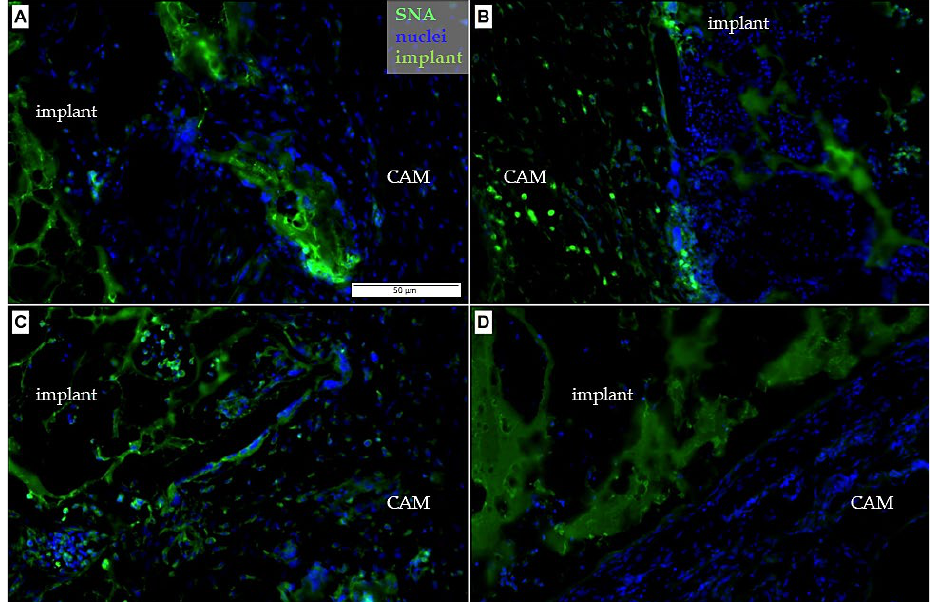
Figure 7. Immunohistochemical detection of the embryonic endothelium in the porous PHB/CHIT scaffolds using the SNA marker. ( A – D ) The presence of the SNA positive cells in the surrounding area of the porous scaffolds as well as inside of the pores of the PHB/CHIT was observed suggesting presence of endothelial cells of blood vessels. Treating of the scaffold in tyrosine kinase inhibitor ( D ) led to lower incidence of endothelial cells in the surrounding area and to absence of these cells inside the pores; scale bar: 50 µm for each picture; biological replicates (6 for each group), technical replicates (48 for each group).